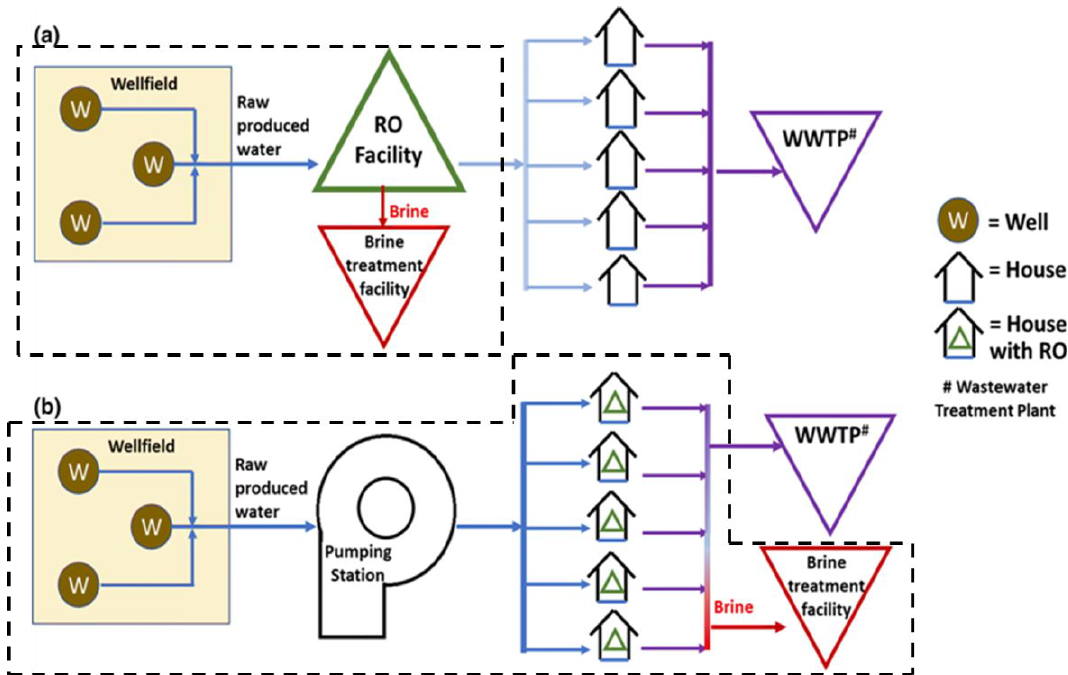
Figure 1. Schematic depiction of two configurations for treatment of coalbed methane (CBM)-produced waters via reverse osmosis (RO) to produce potable drinking water. ( a ) In the centralized configuration, the produced water is treated near the wellfield and brine disposal occurs at the treatment location. ( b ) In the decentralized configuration, the produced water is pumped to individual homes where point-of-use RO is applied, and brine wastes are then collected or discharged to a secondary location for treatment. Dashed lines indicate the system boundaries for this study. The figure is an adaptive extension from [6].